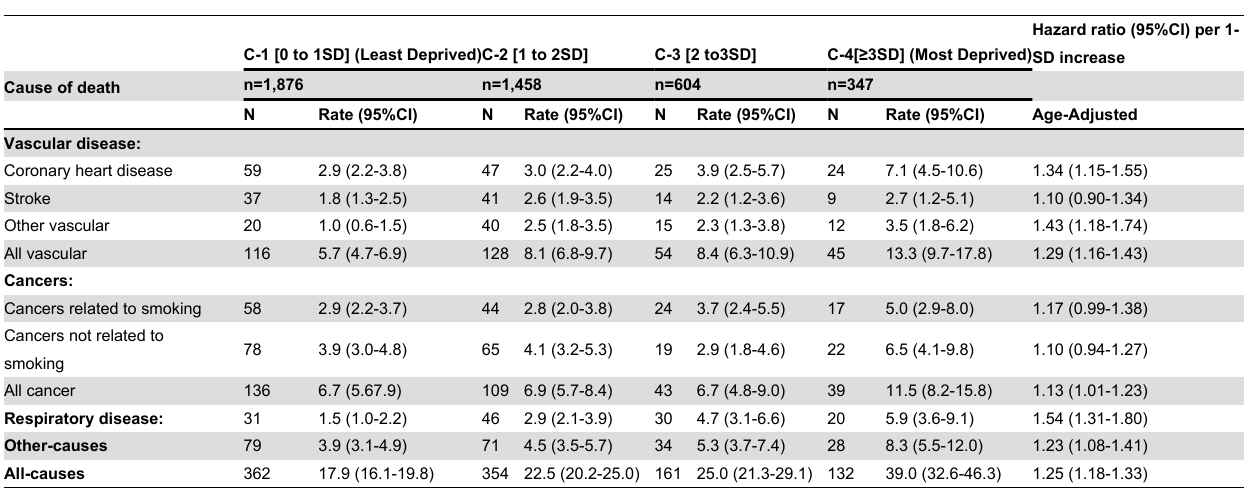
Table 3. Number of deaths (N) and rate per 1,000 person-year (95%CI) of overall and cause-specific mortality across categories of the